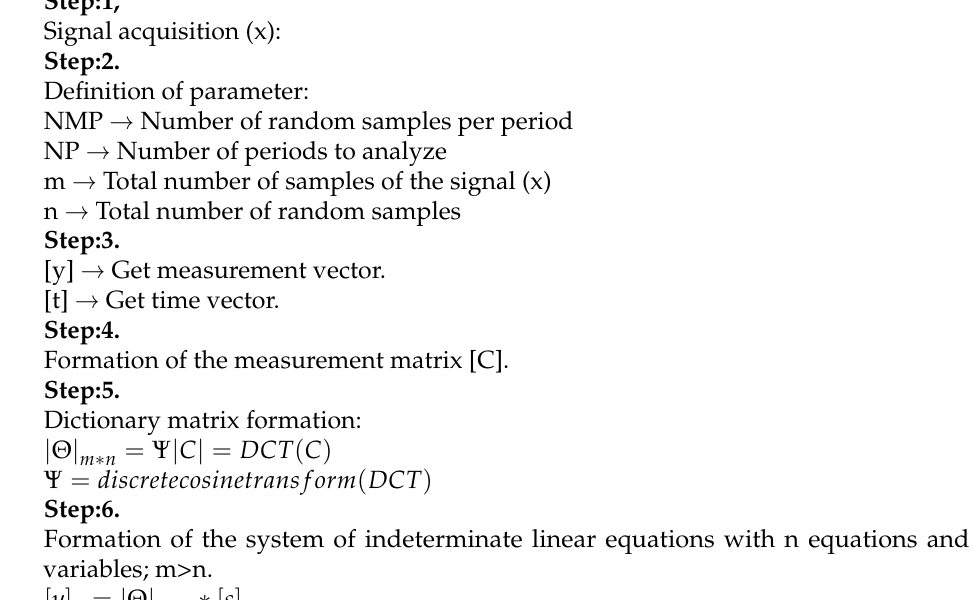
Algorithm 1 Harmonic detection with the CS